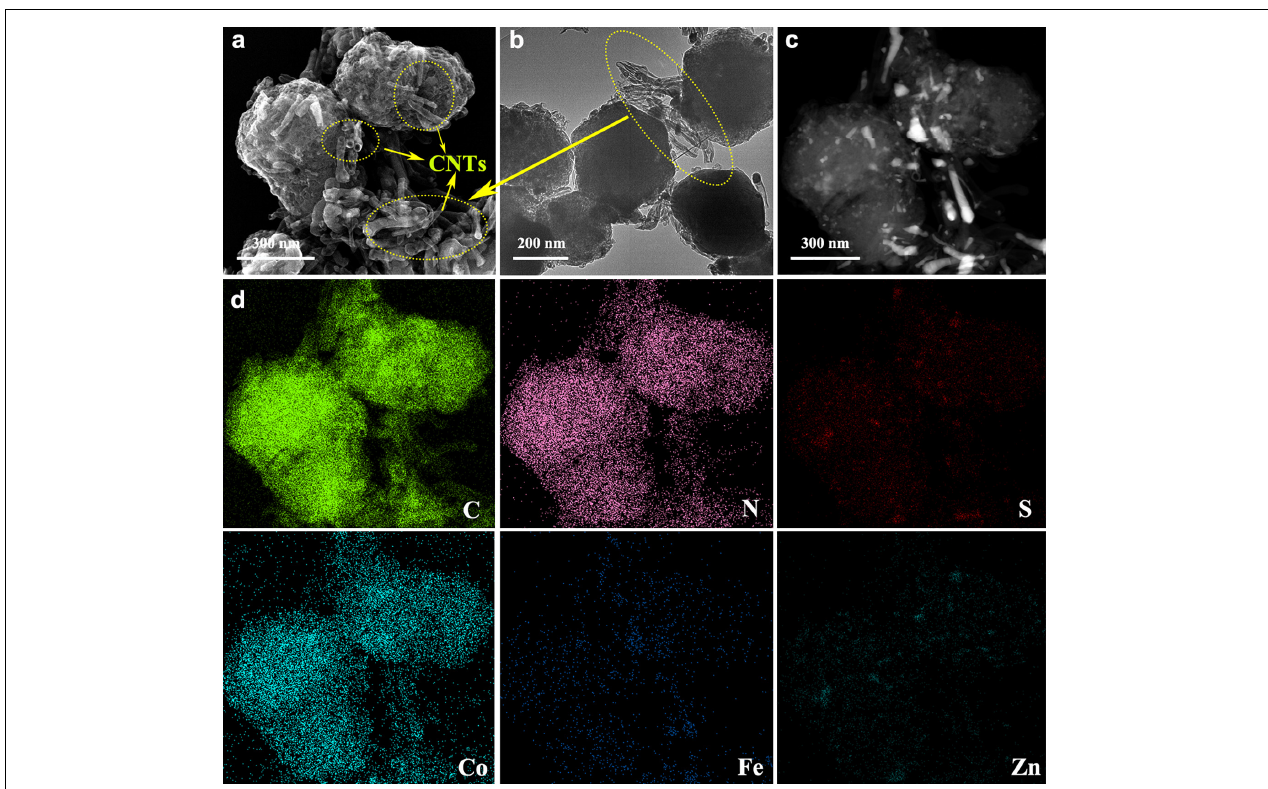
FIGURE 3 | Transmission electron microscopy images of (a–c) Zn/Co/Fe–S–NC-900 catalyst and (d) the corresponding element mapping images (C, N, S, Co, Fe, Zn).